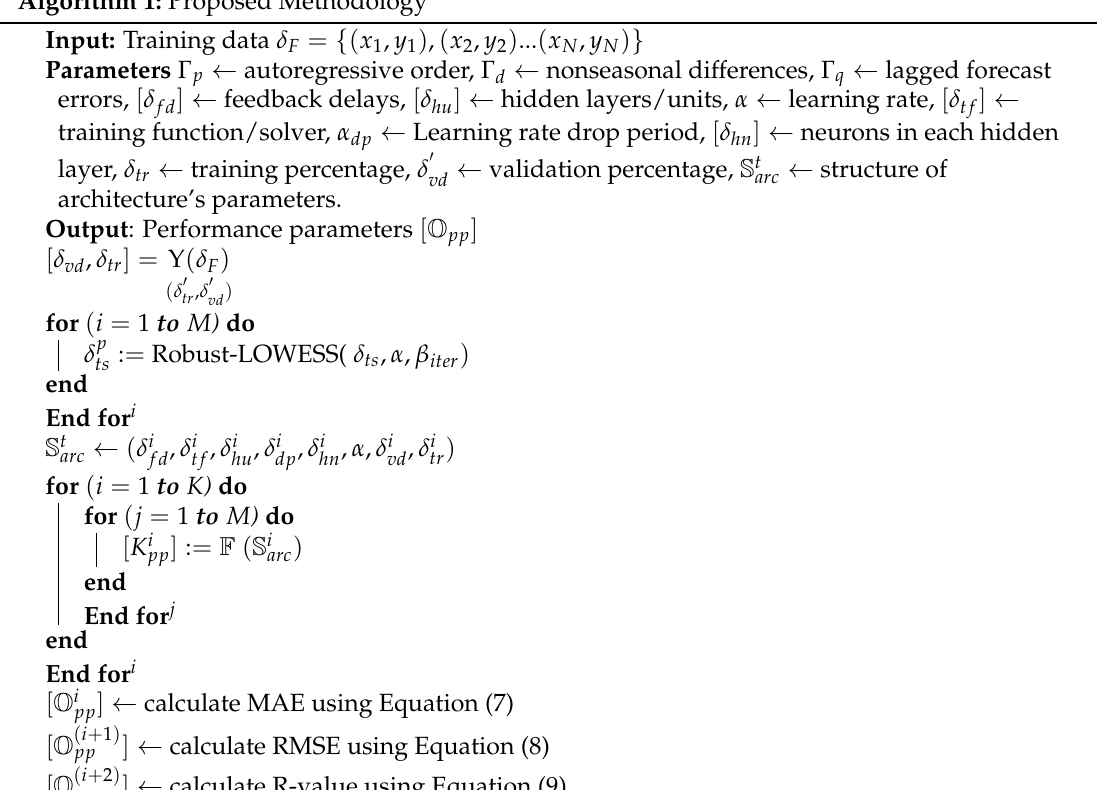
Algorithm 1: Proposed